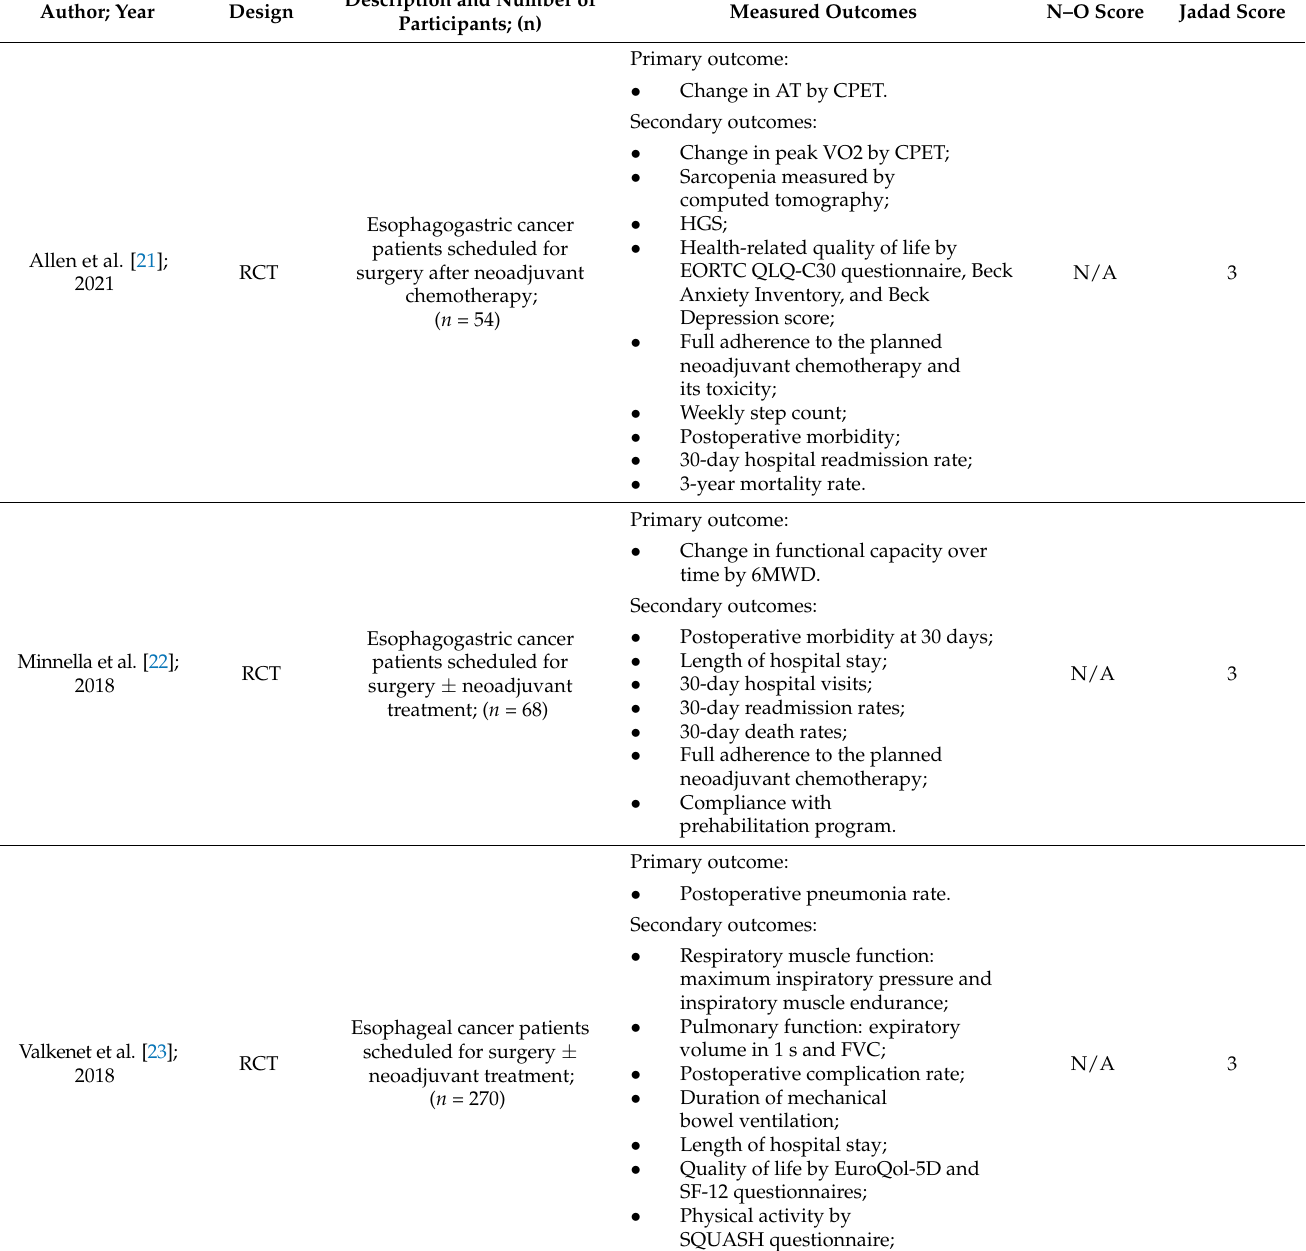
Table 1. Characteristics of studies investigating prehabilitation for esophagogastric cancer